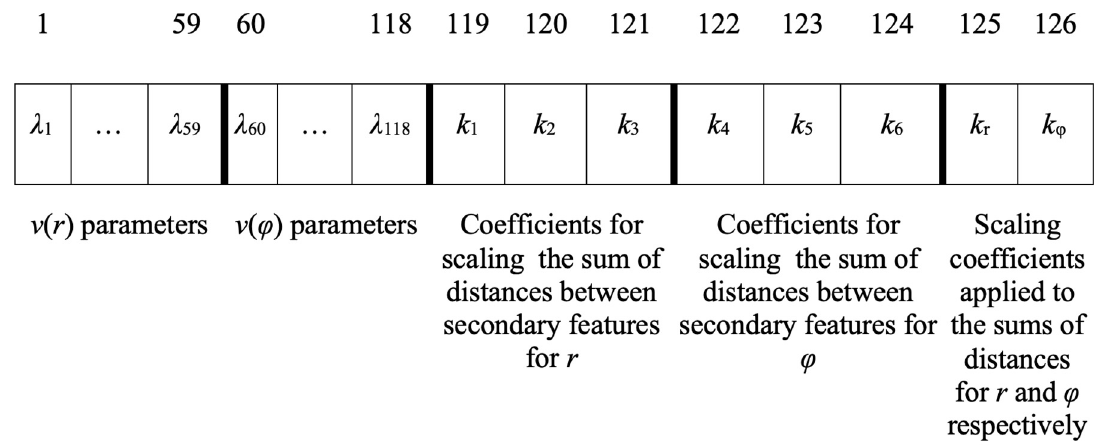
Figure 5. Parameters encoded in a genetic algorithm’s individual chromosome.